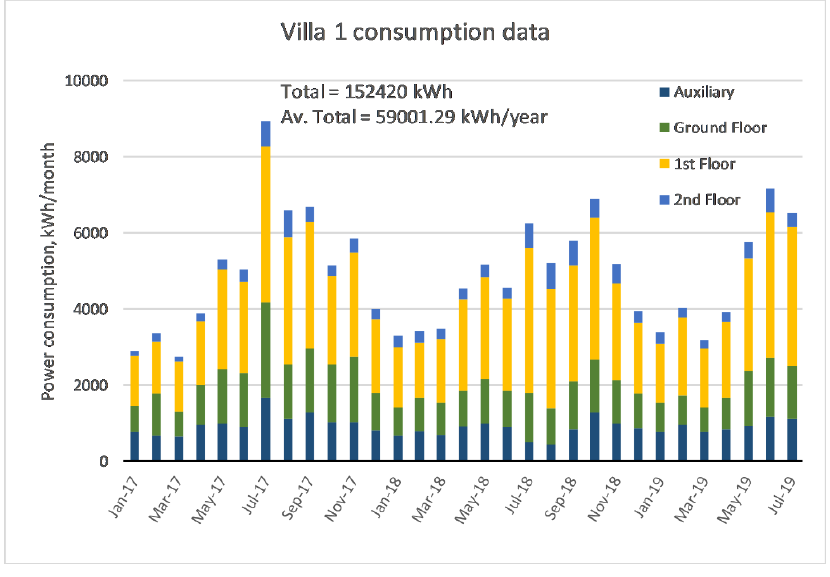
Figure 20. Consumption for Villa 1 for 31 months, from January 2017 until July 2019. Energies 2019 , 11 , x FOR PEER REVIEW